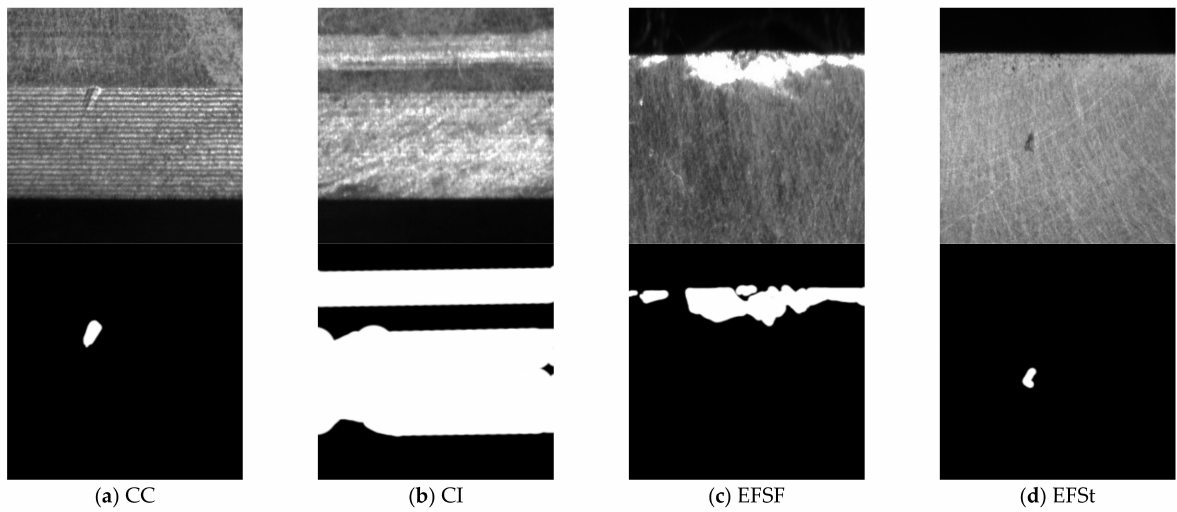
Figure 8. The samples with large scale difference of surface defects of roller and their corresponding defect labeling positions.